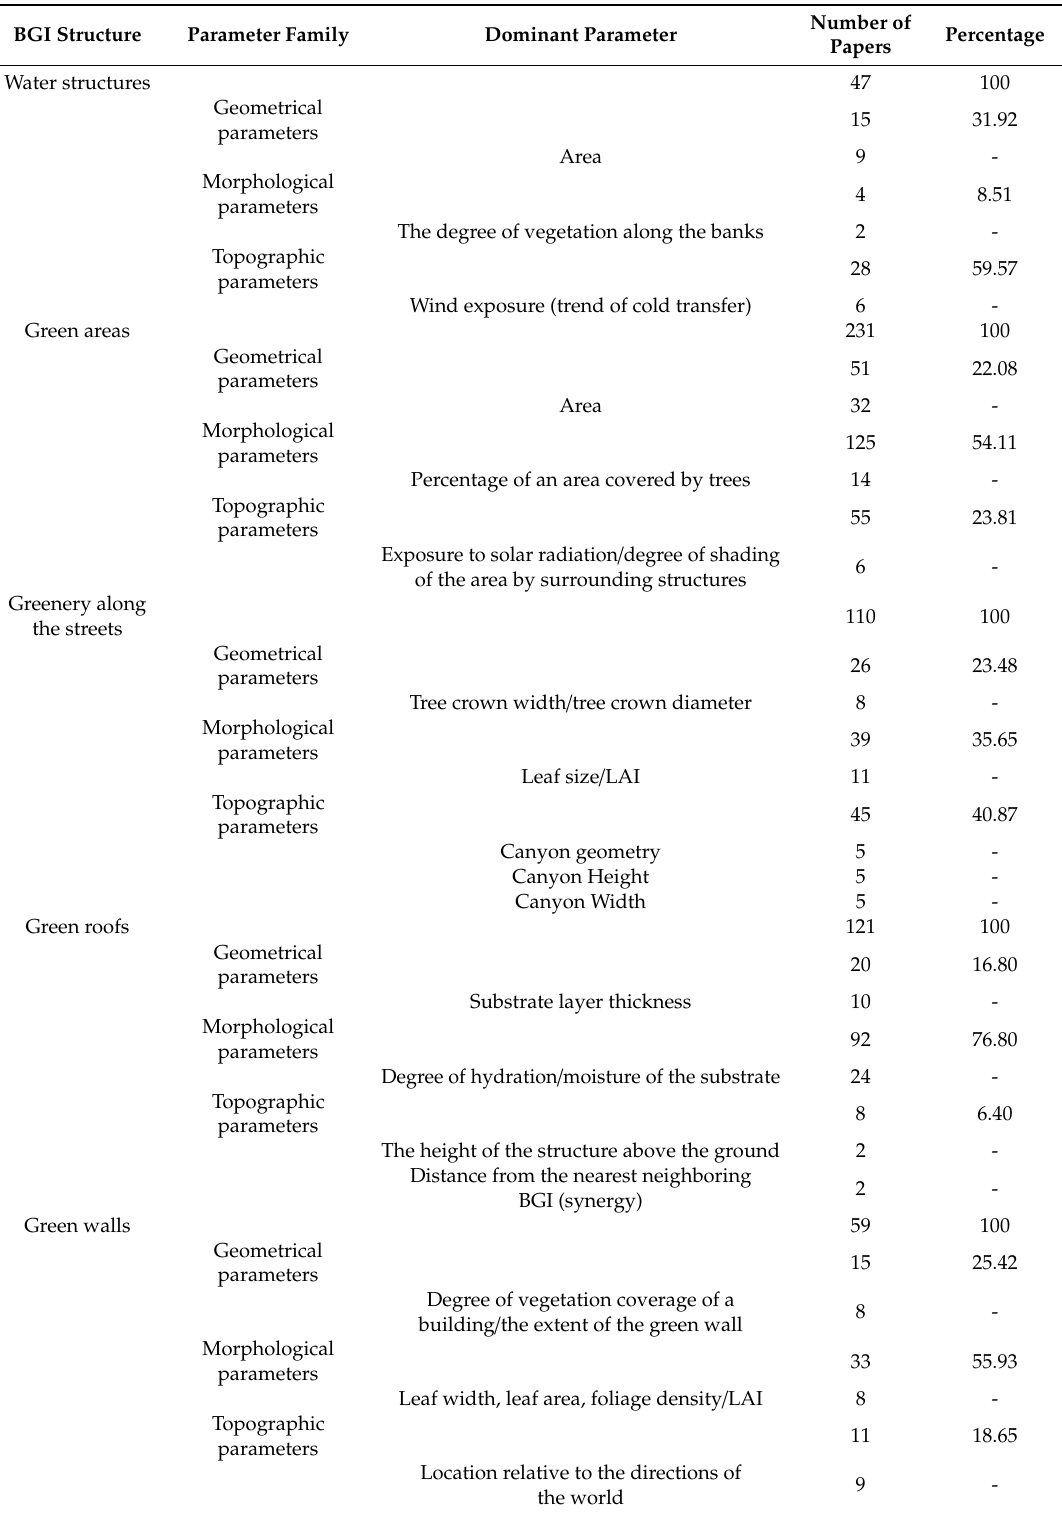
Table 3. Classification of the significance of design parameters of BGI elements a ff ecting UHI mitigation in a warm temperate climate